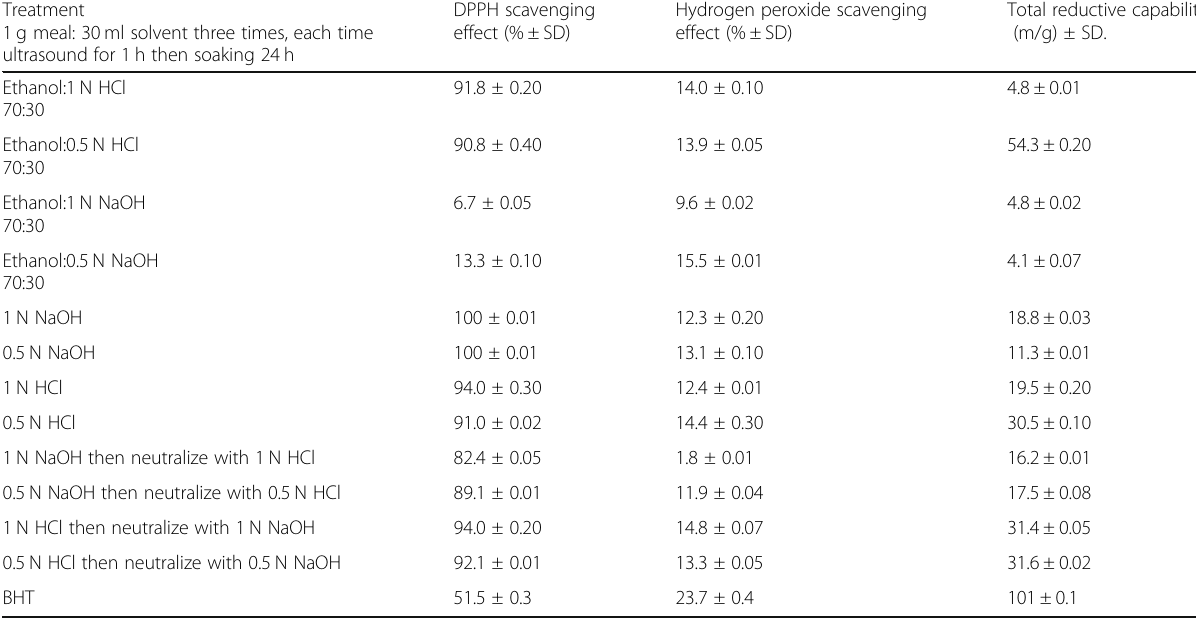
Table 4 Antioxidant activity of jatropha hull extracts at room temperature Treatment 1 g meal: 30 ml solvent three times, each time ultrasound for 1 h then soaking 24